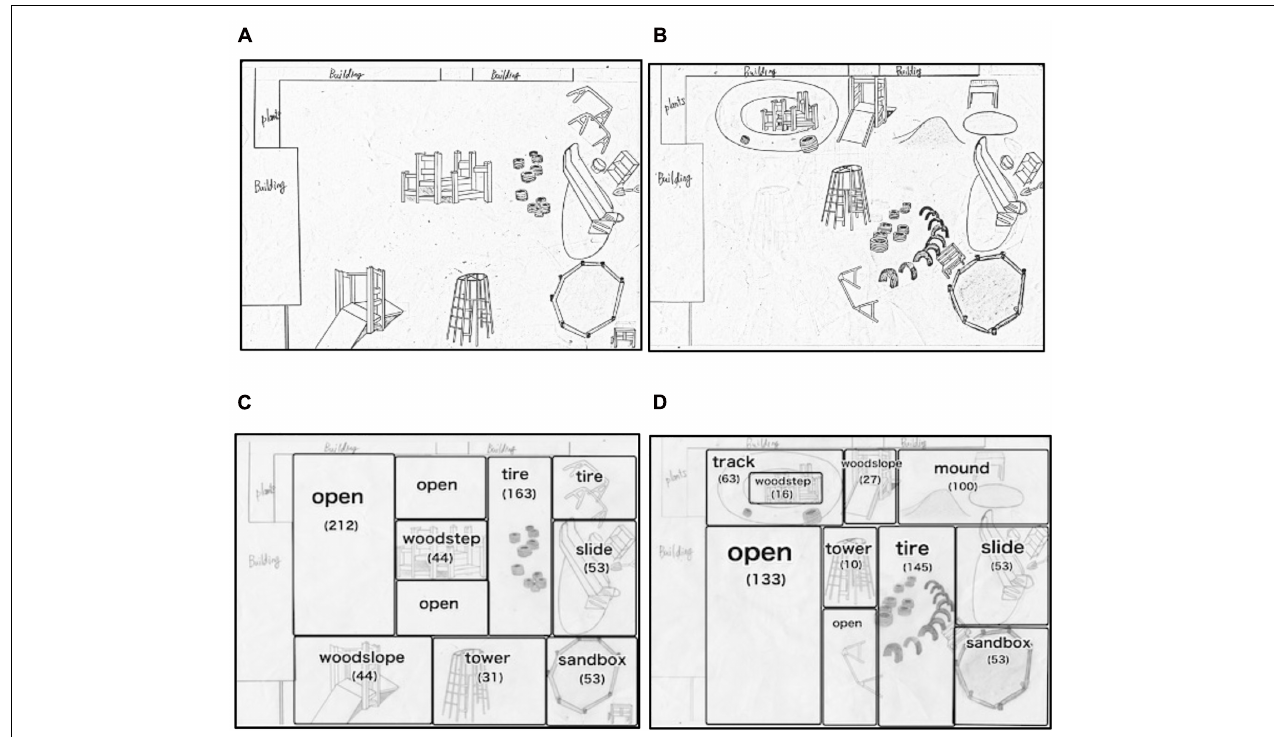
FIGURE 1 | Illustration of the spatial layout of the playground and the area separations for observation. (A,B) illustrate the spatial layout before and after the alteration, respectively. (C,D) indicate area separations before and after the alteration, respectively. The numbers indicated below the area name are the square meters (m 2 ) of the